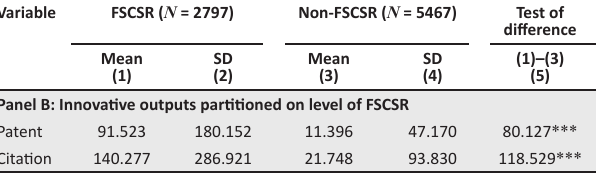
TABLE 2B: Univariate